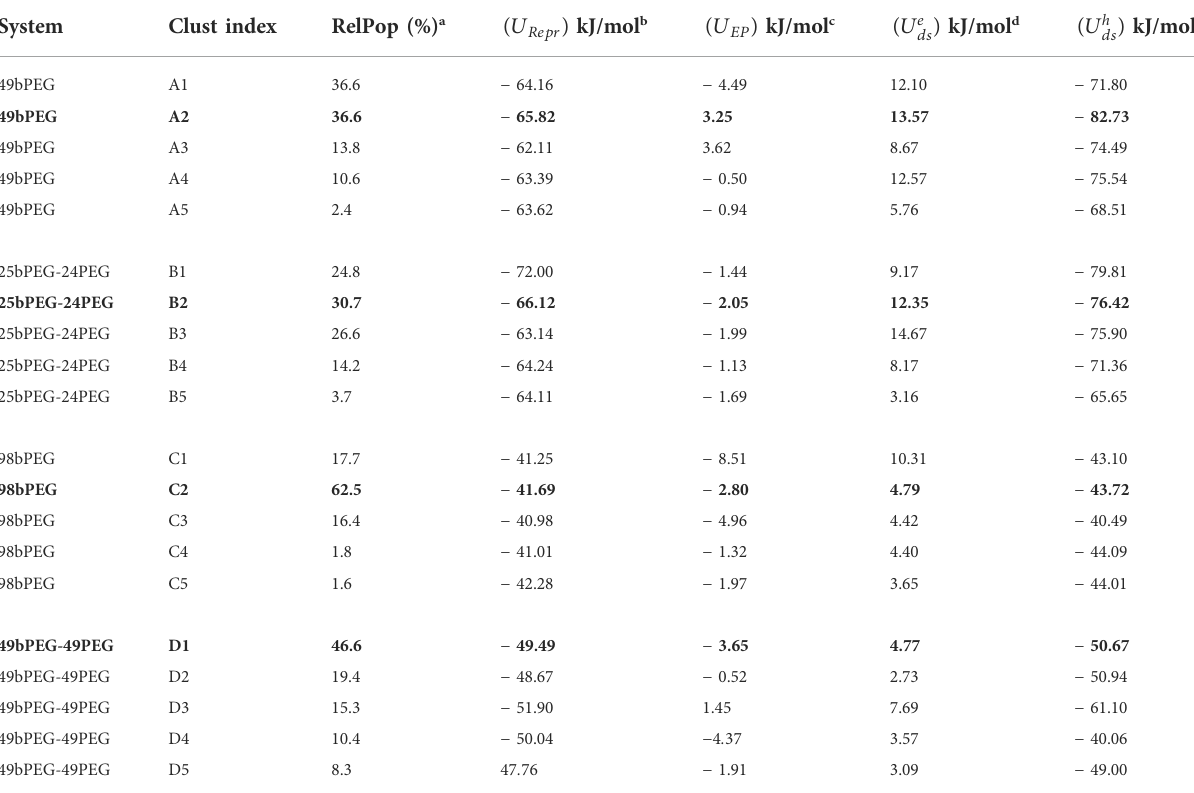
TABLE 1 Au (111) with different functionalizations docked with Streptavidin, results as obtained from SDA.